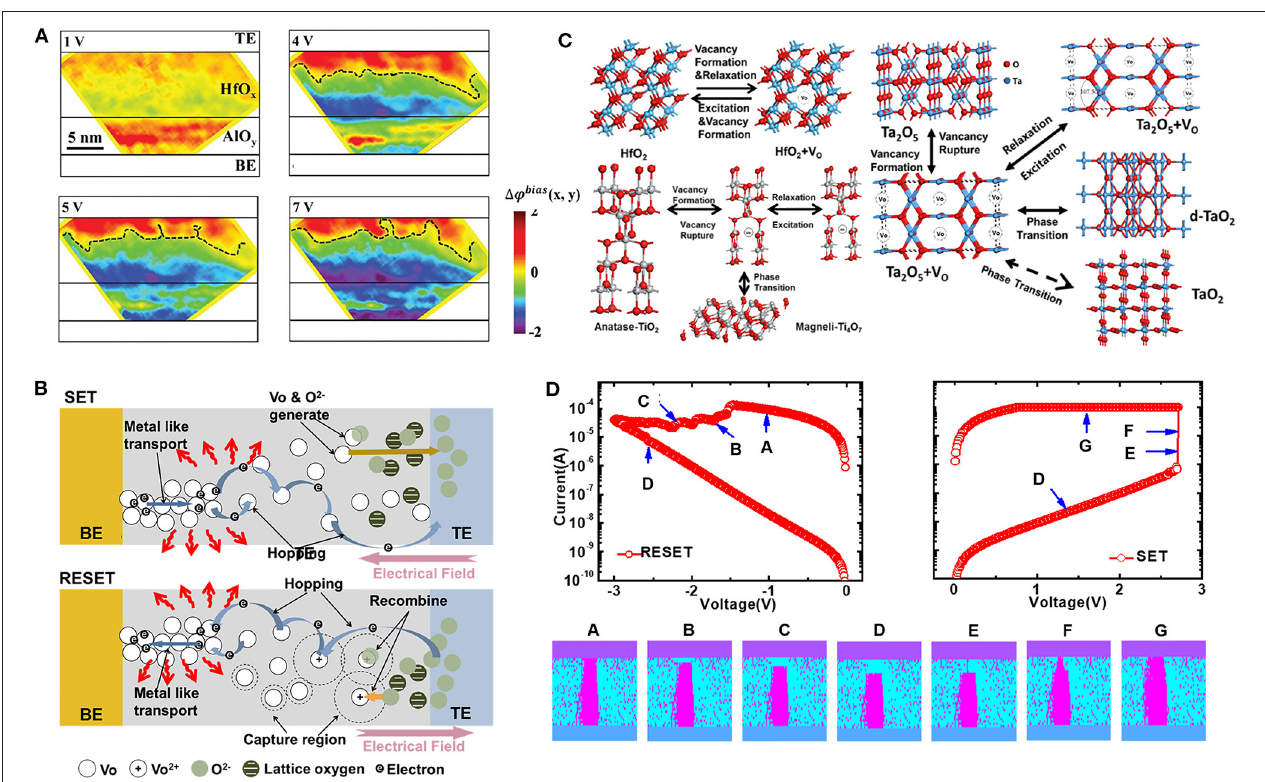
FIGURE 1 | (A) The bias-induced phases featuring 1 ϕ bias (x,y) in the forming process of HfOx- resistive switching random access memory (RRAM). The intrinsic inner potential is removed by using the phase image of the pristine sample without bias. The dash curve is the boundary between the positive and negative phases. TE, top electrode; BE, bottom electrode. (B) Physical effects during SET and RESET processes. (C) Ab initio calculation results for various metal oxide materials such as HfO 2 , TiO 2 , and Ta 2 O 5 . (D) I–V curves and the corresponding CF evolutions simulated by the kinetic Monte Carlo method during RESET and SET processes. Reprinted from Kang et al. (2015), Huang et al. (2013), and Li et al.